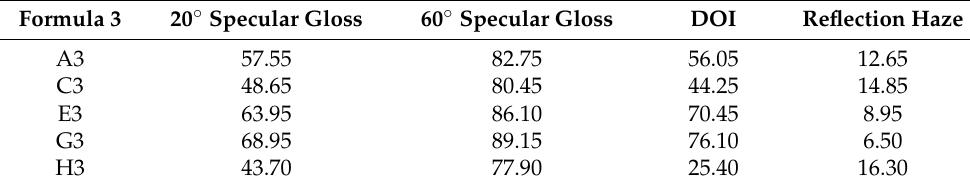
Table 15. The coating surface quality results of coatings prepared by Formula 3. Formula